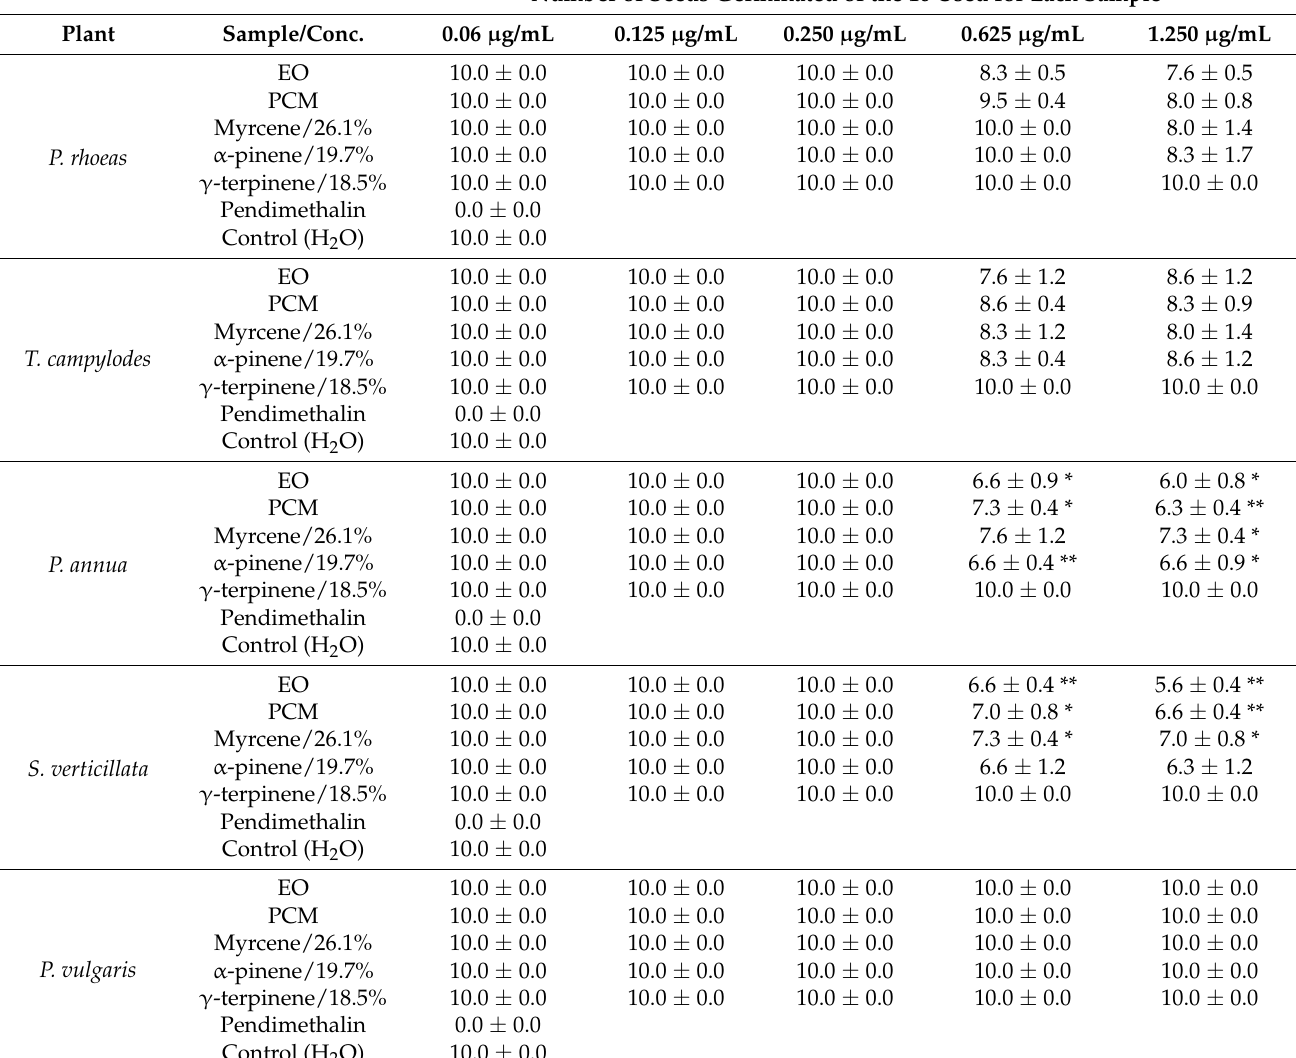
Table 2. Antigerminative activity—namely the ability of Ferulago campestris EO, pure compounds mixture (PCM), and main EO compounds to inhibit the germination of the seeds used in the experiment ( Papaver rhoeas, Taraxacum campylodes, Poa annua, Setaria verticillata, and Phaseolus vulgaris